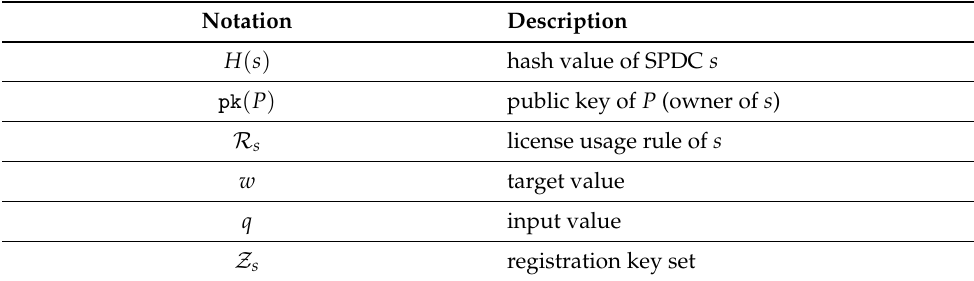
Table 3. A list of information stored in the account of SPDC s owned by P